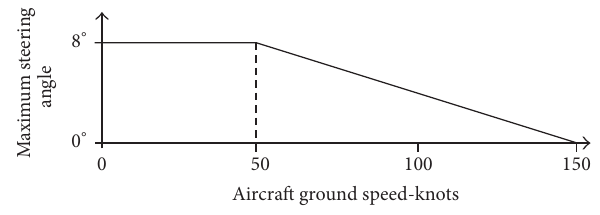
Figure 9: Rudder pedal operation model.